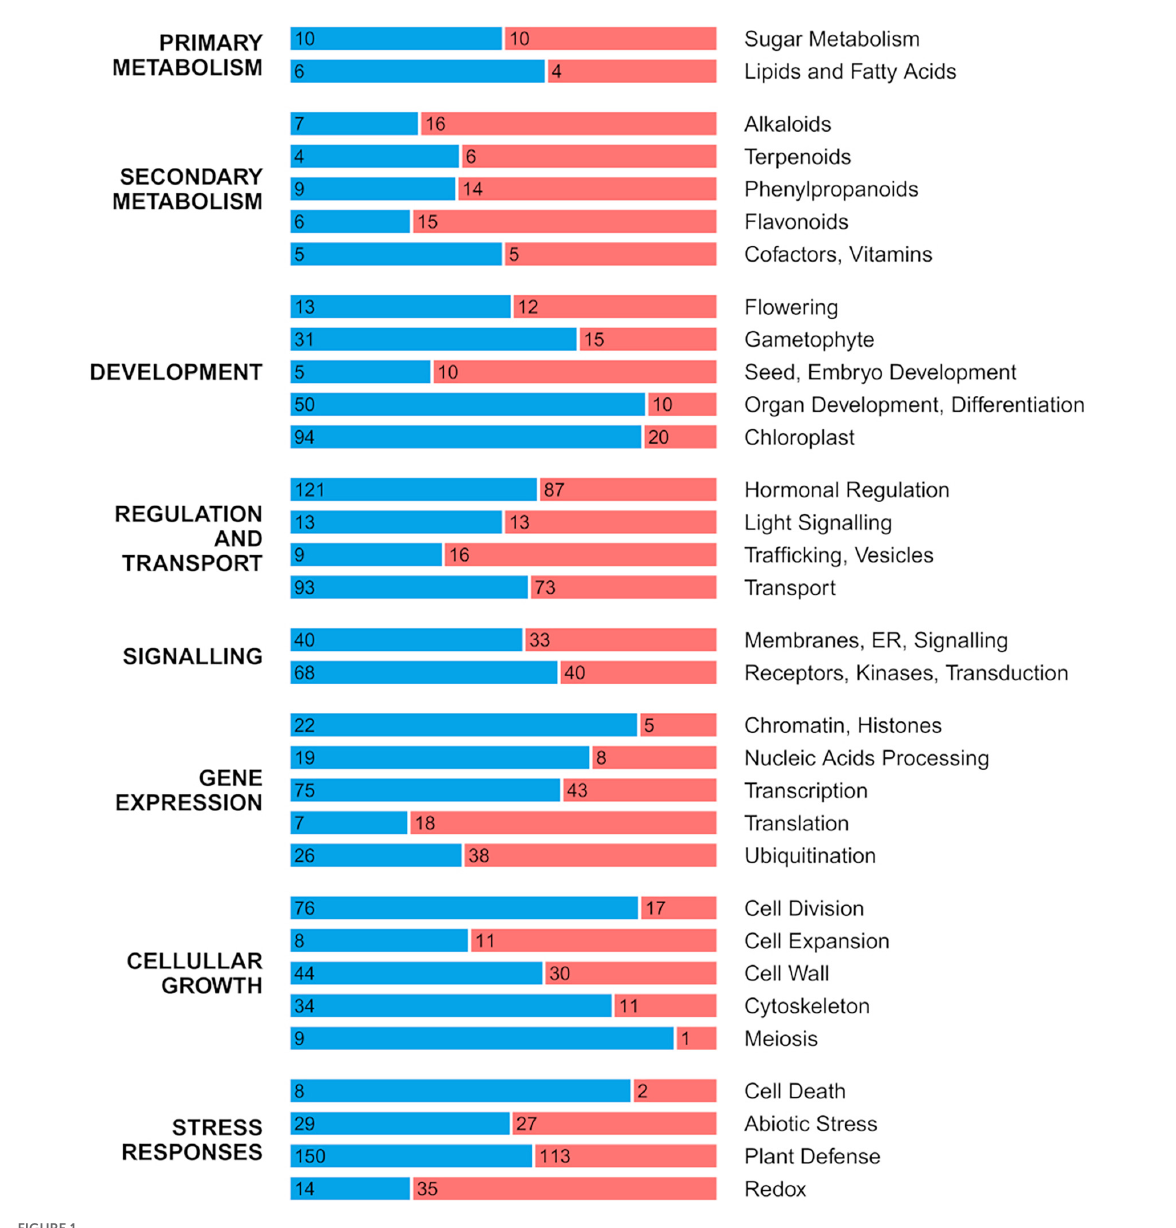
Supplementary Table 2 ) is repressed in this species. This